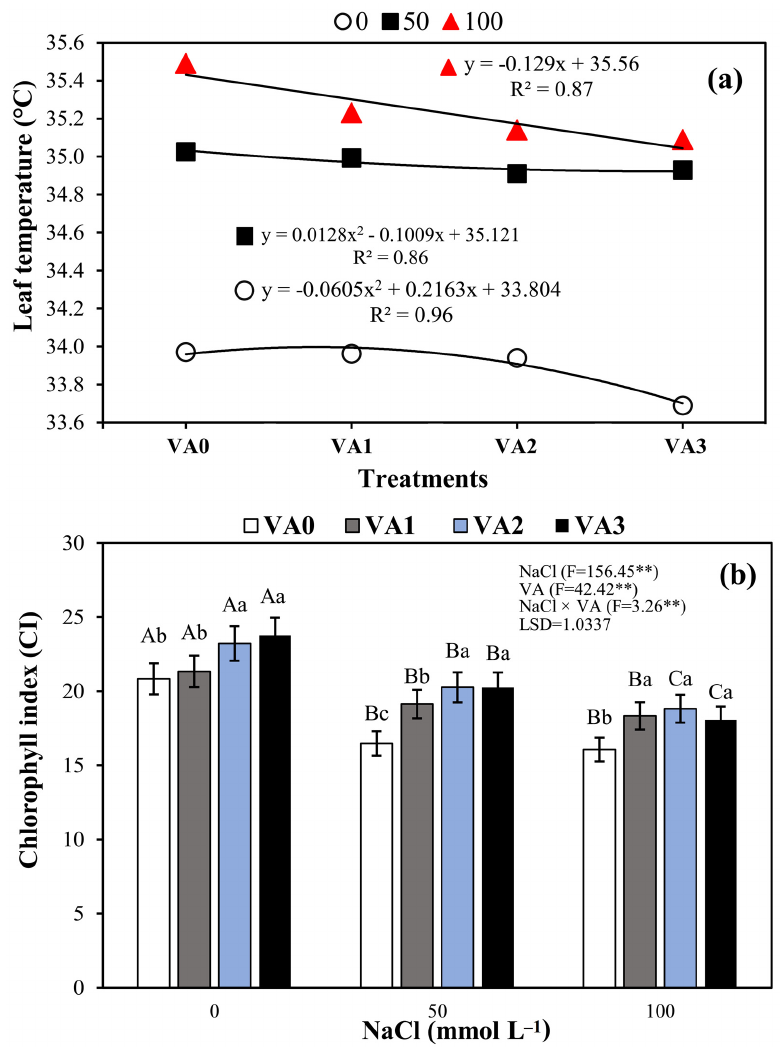
Figure 4. Leaf temperature ( a ) and leaf chlorophyll index ( b ) of soybean plants under different levels of salt stress and VA application. Plants were submitted to four concentrations of VA (VA0, non-VA application; VA1, 0.4 mL L − 1 ; VA2, 0.8 mL L − 1 ; and VA3, 1.2 mL L − 1 ) and three levels of NaCl (0, 50, and 100 mmol L − 1 ). Data are mean ± SD (n = 5). In Figure 4b, uppercase letters above bars indicate significant differences among NaCl concentrations at the same VA concentration. Lowercase letters above bars indicate differences among VA concentrations at the same NaCl concentration, according to LSD test ( p < 0.05). F values from ANOVA: ** p < 0.01. Concentrations of 100, 50, and 0 mmol L − 1 of NaCl are represented by ( ▲ ), ( ■ ), ( ○ ), respectively.